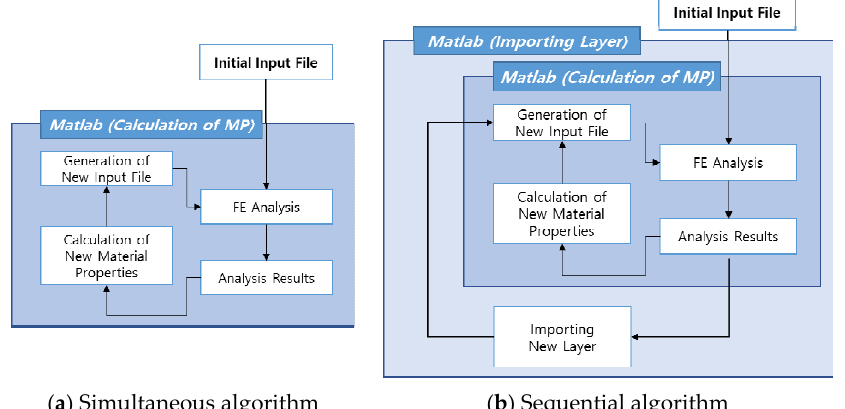
Figure 4. Flow charts of two algorithms.